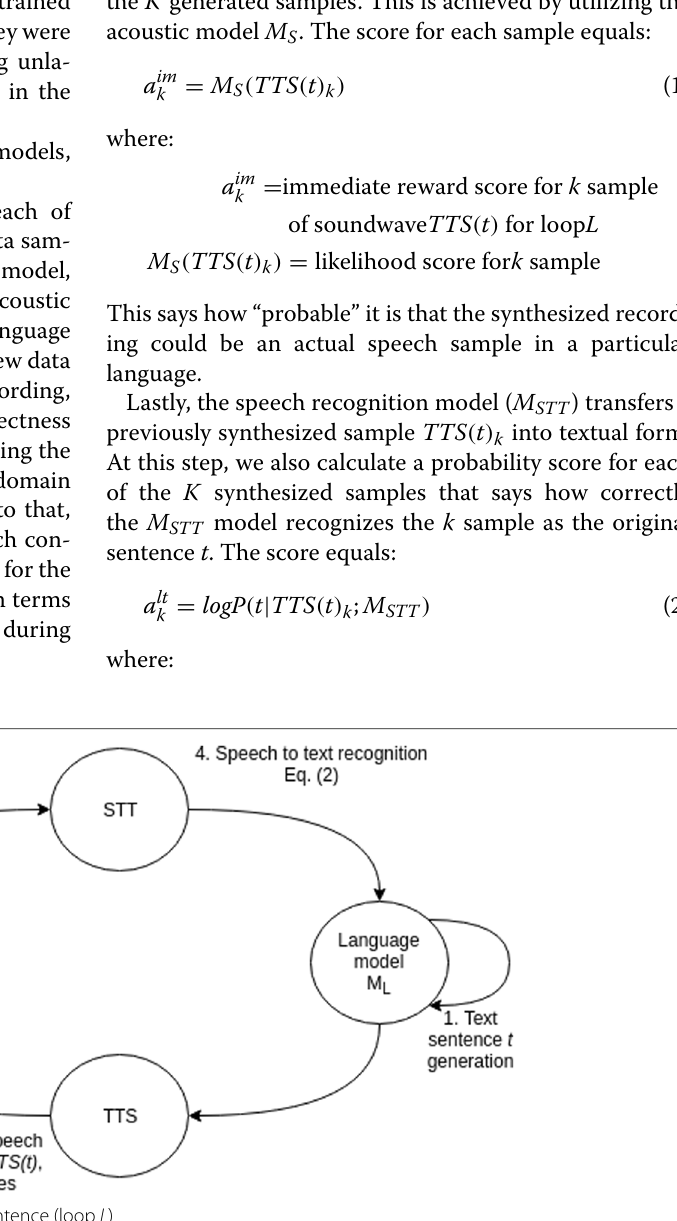
Fig. 1 Feedback loop design. Loop starts with generating a sentence (loop L